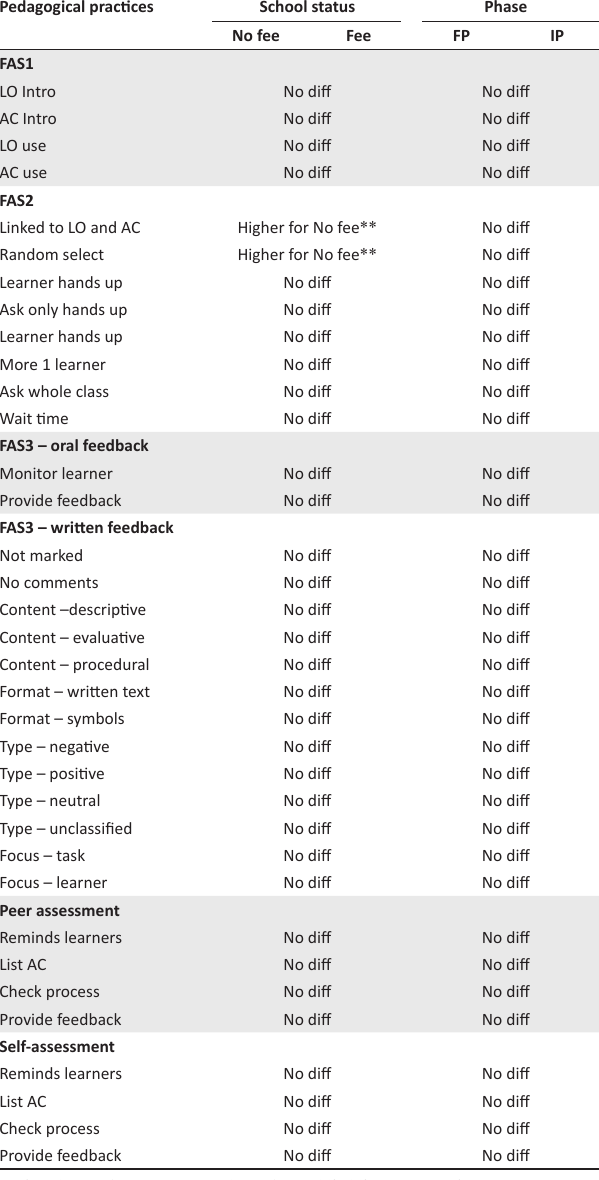
FIGURE 1-A1: Results of chi-square analysis comparing fee versus no-fee and foundation phase versus intermediate